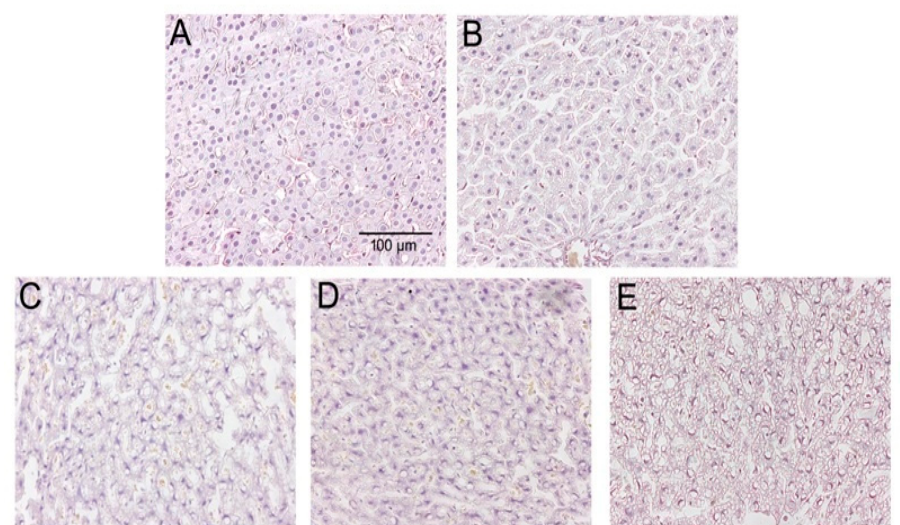
Figure 3. HE staining of liver tissues from five studied groups. ( A ) HE staining in Con group. ( B ) HE staining in 13% F group. ( C ) HE staining in 20% F group. ( D ) HE staining in BPA group. ( E ) HE staining in 13% F + BPA group. Original magnification 200×. Con, control group; F, fructose group; BPA, 1 µg/mL BPA group.